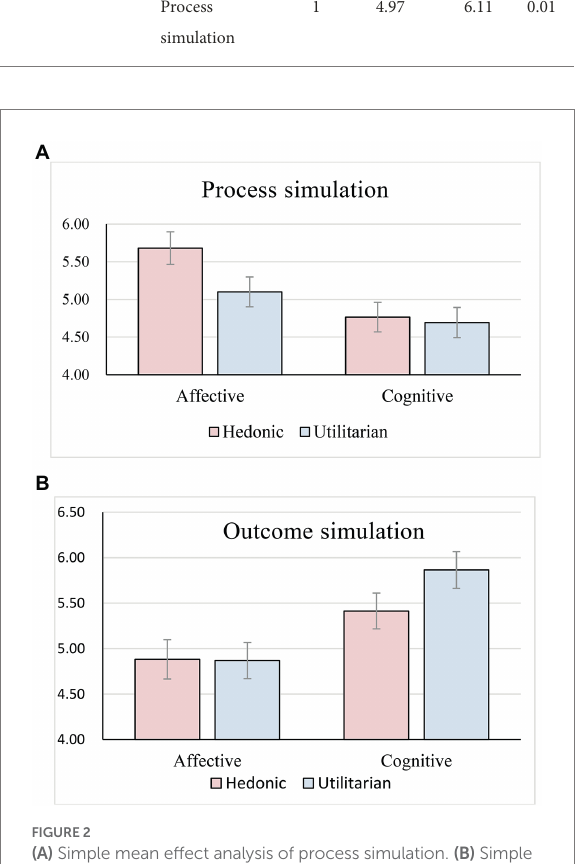
FIGURE 2 (A) Simple mean effect analysis of process simulation. (B) Simple mean effect analysis of outcome